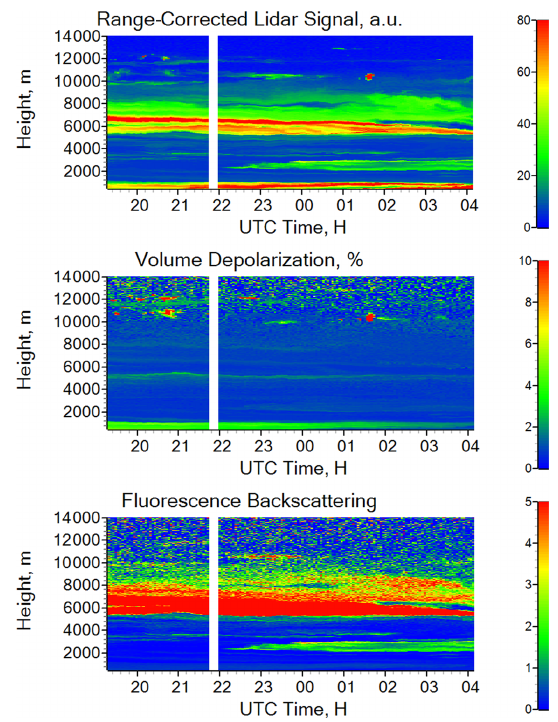
Figure 7. Formation of ice particles at heights above 10km inside a smoke layer on 11–12 September 2020. Spatiotemporal varia- tions in range-corrected lidar signal at 1064nm, volume depolar- ization ratio at 1064nm and fluorescence backscattering coefficient (in 10 − 4 Mm − 1 sr − 1